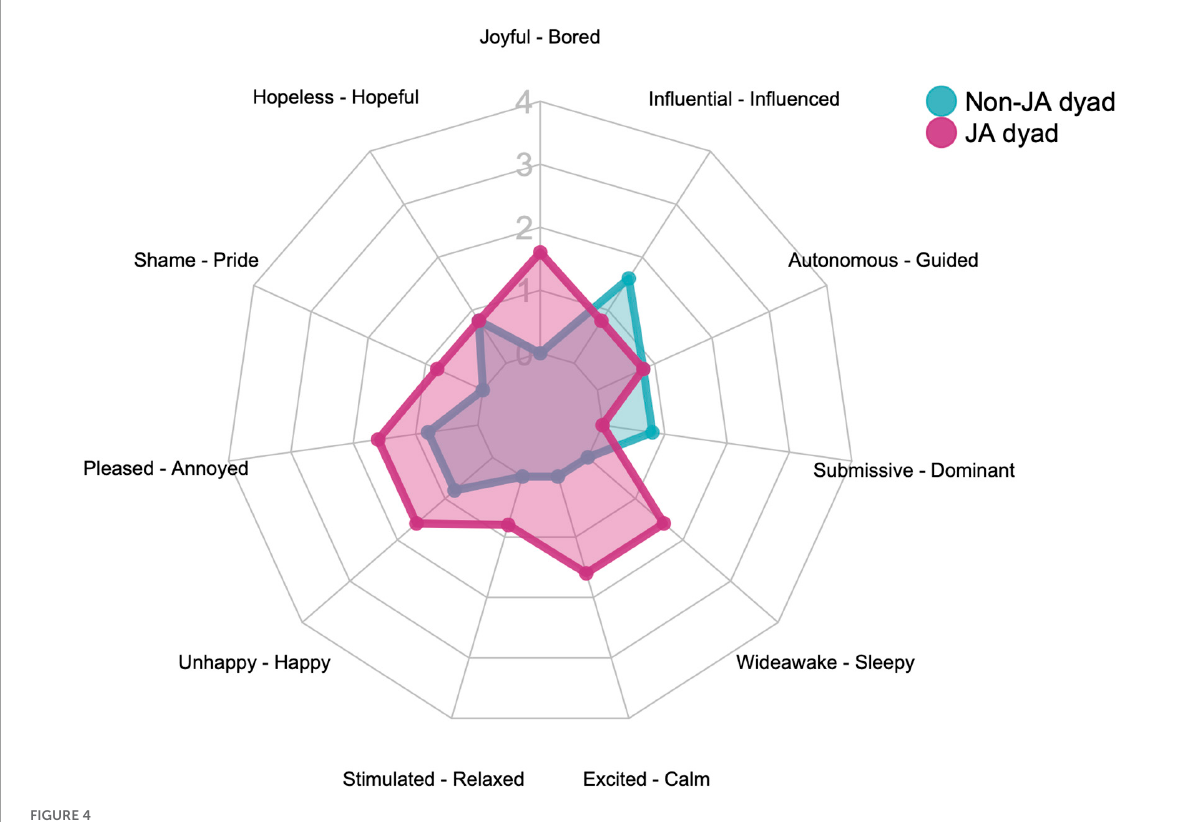
FIGURE4 Radar graph of subjective emotional state rating differences within dyads. The small plane size formed on the radar graph indicates an emotional “in-sync”